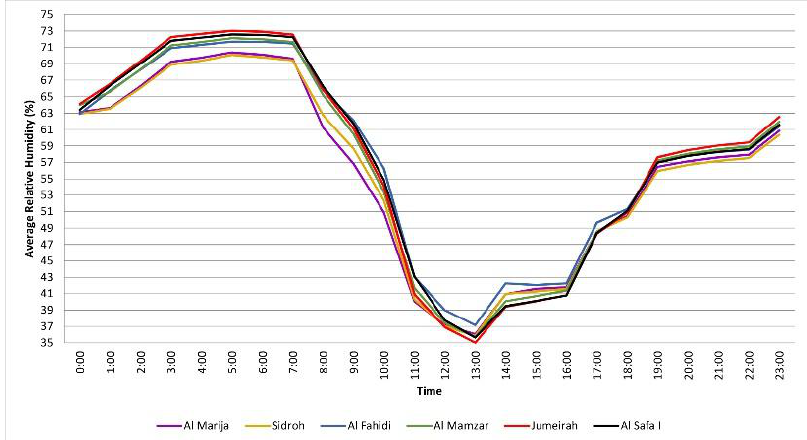
Figure 16. Hourly variations of relative humidity (%) for Al Marija, Sidroh, Al Fahidi, Al Mamzar, Jumeirah, and Al Safa I in April. Table 6. Sky view factor for the six sites. (Images generated by ENVI-met).